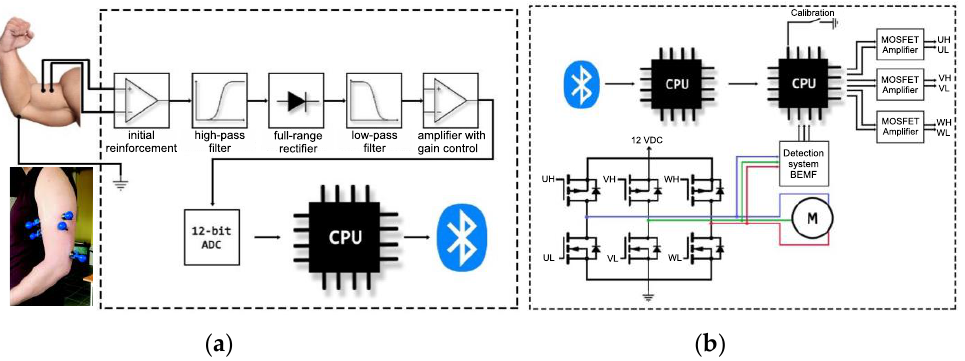
Figure 1. General scheme of the measurement system construction ( a ), diagram of the actuating system ( b ).